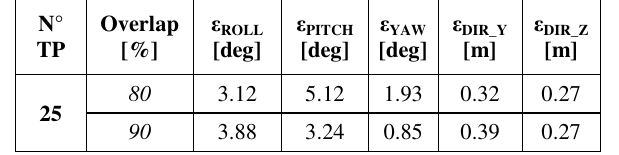
Table 10. Error propagated – 25 TP – simulation